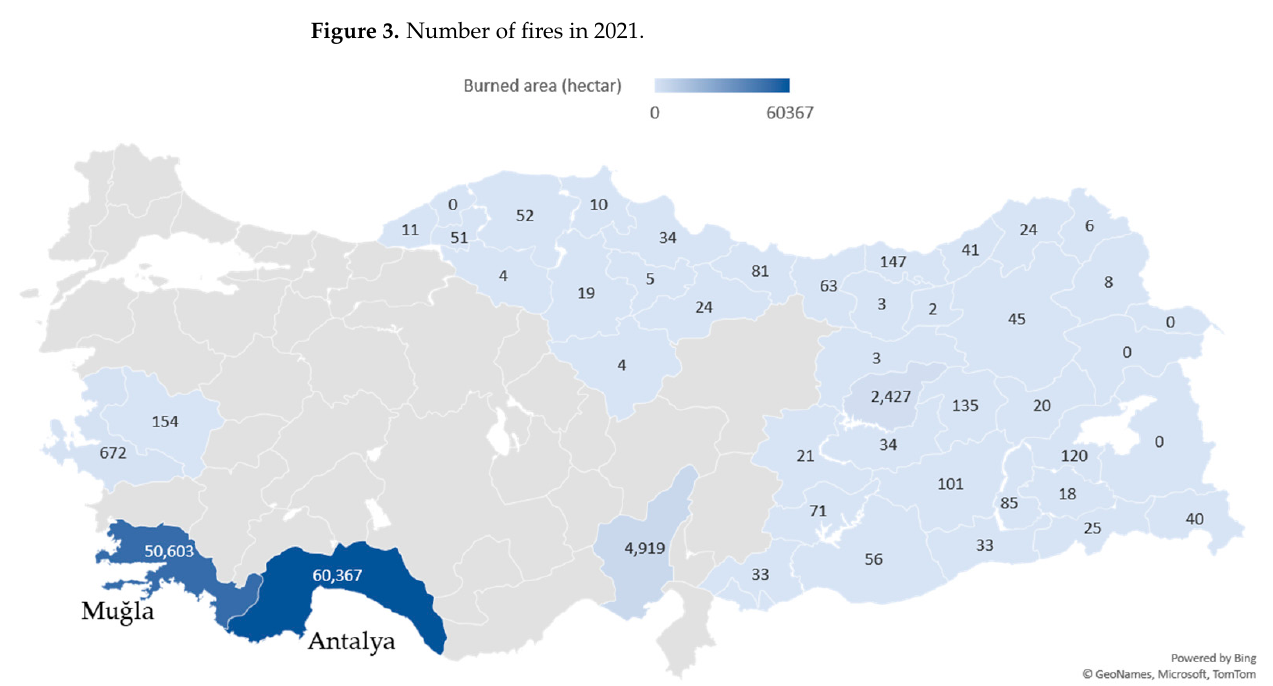
Figure 3. Number of fires in 2021.